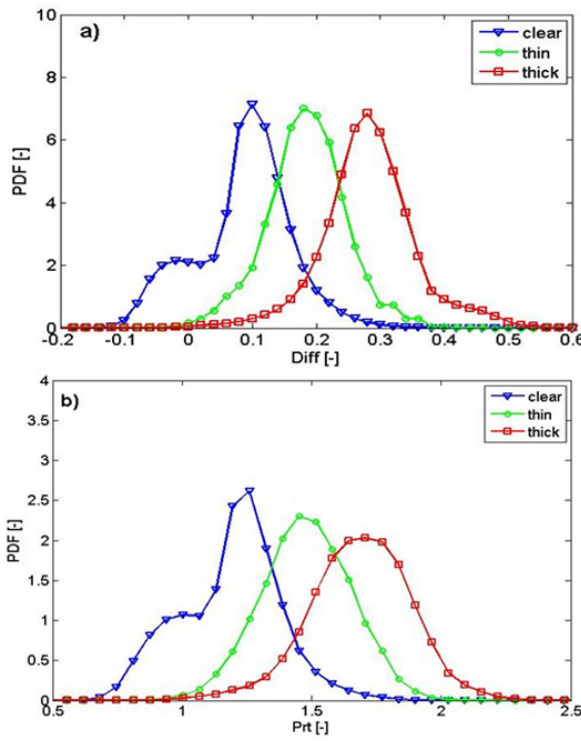
Fig. 8. PDF of the training set for each class without HCF applied for (a) Diff (Eq. 5); (b) Prt (Eq.